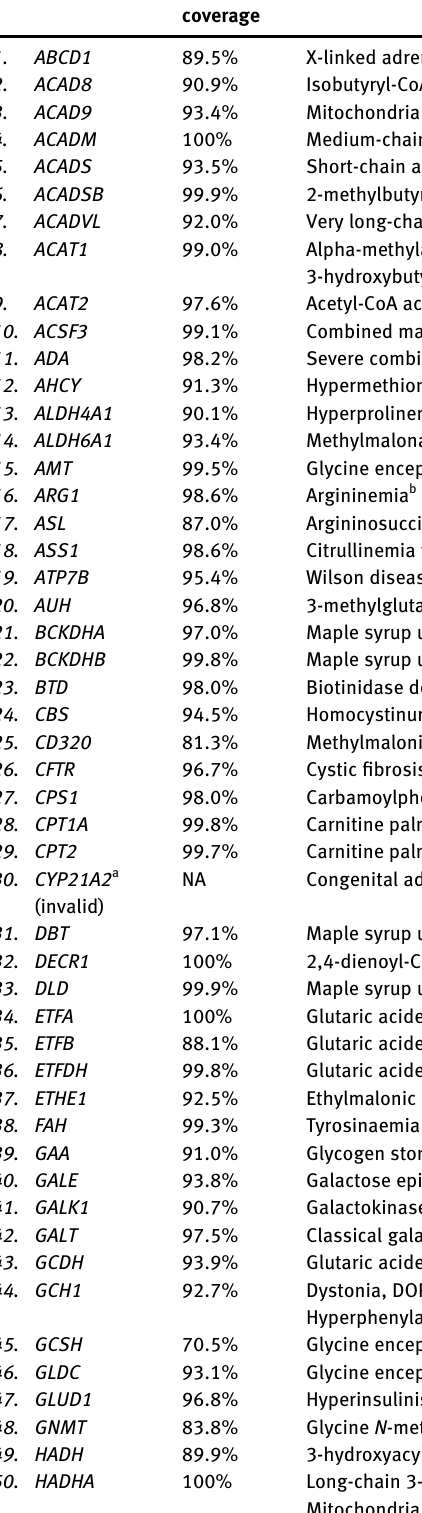
Table  : List of the panel genes with individual >  × coverage and the associated disease. Gene ≥  × coverage